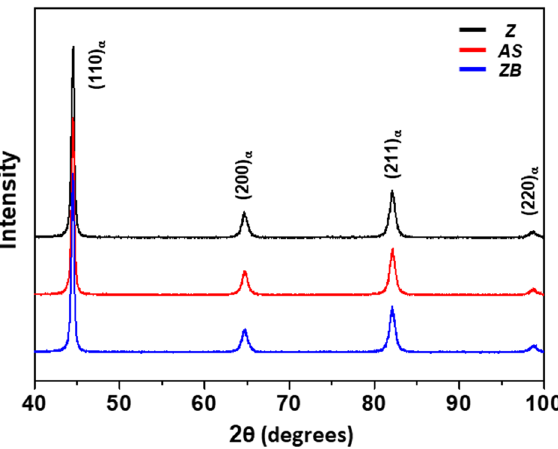
Figure 2. X-ray diffraction patterns of the Z, AS, and ZB steels, showing peaks of body-centered-cubic (BCC) phase.